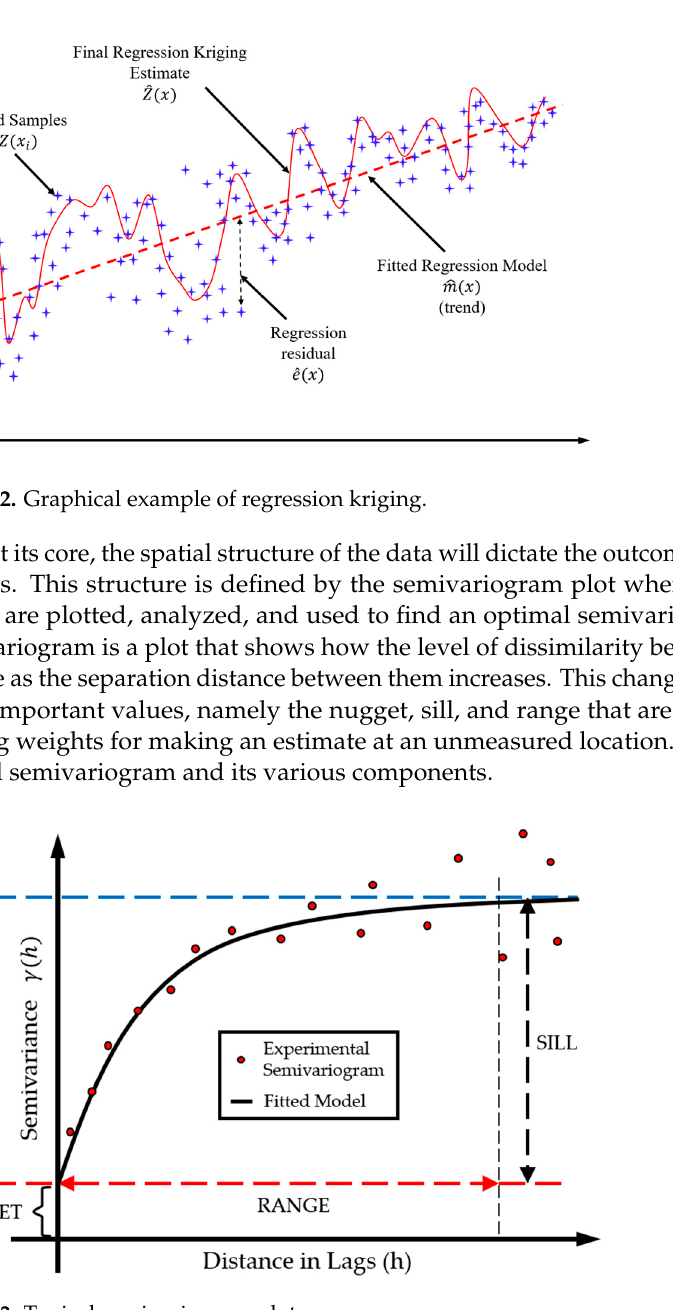
Figure 3. Typical semivariogram plot.